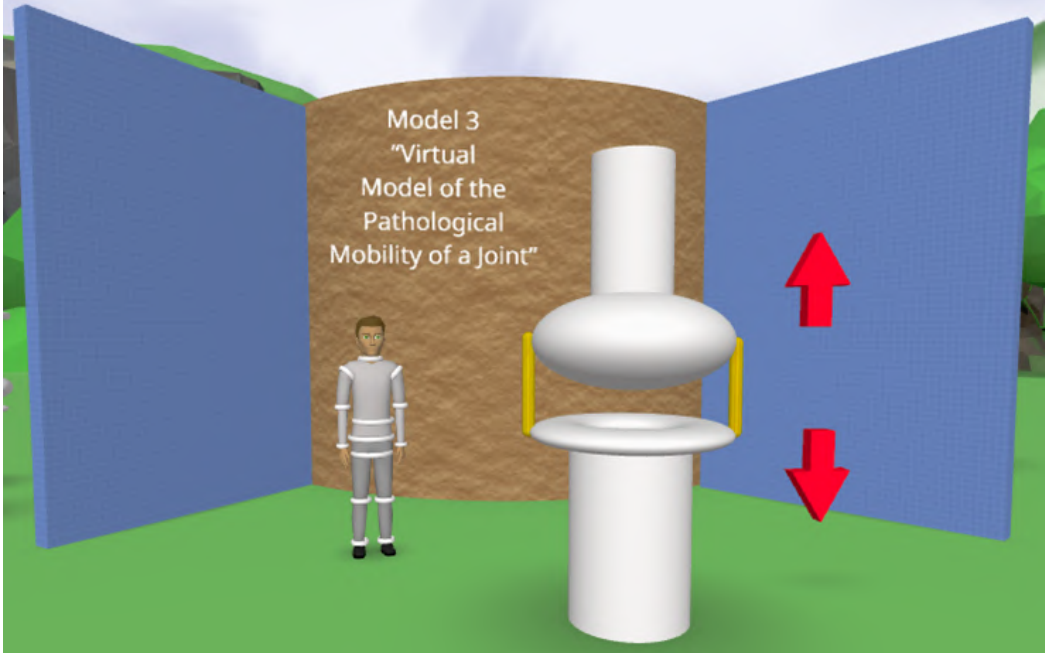
Figure 11: “Virtual Model of Identifying the Risks for Locomotor Apparatus Caused by Ligament Stretching”: Model 3 – “Virtual Model of the Pathological Mobility of a Joint”